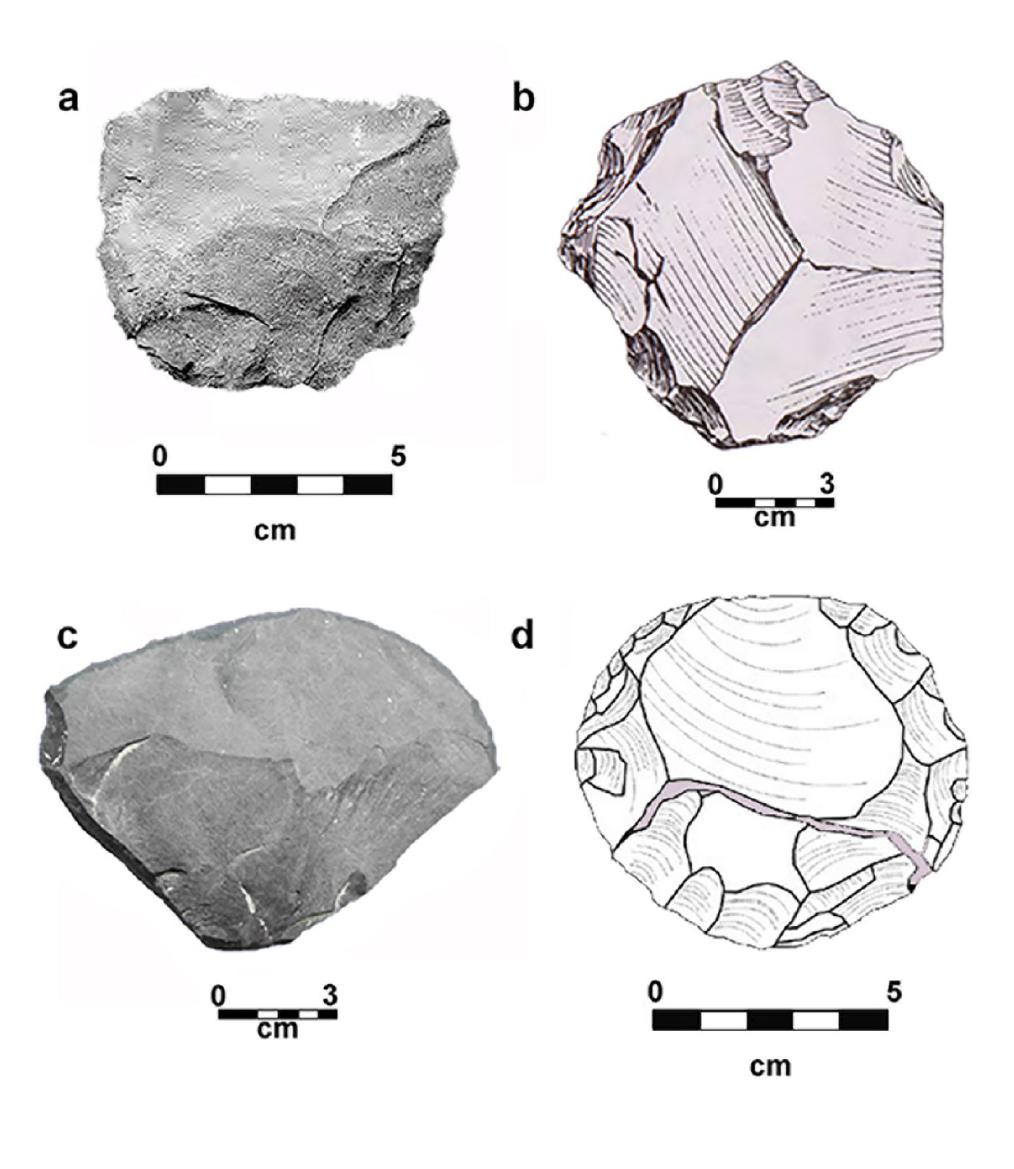
Figure 2. Examples of Levallois products. References: a) Levallois flake removed from a core exhibiting centripetal extractions and prepared platforms from the locality of Cañadón de los Mejillones (modified from Franco et al. 2010: fig. 2), b) possible Levallois core from the site of Laguna Pali Aike (modified from Nami